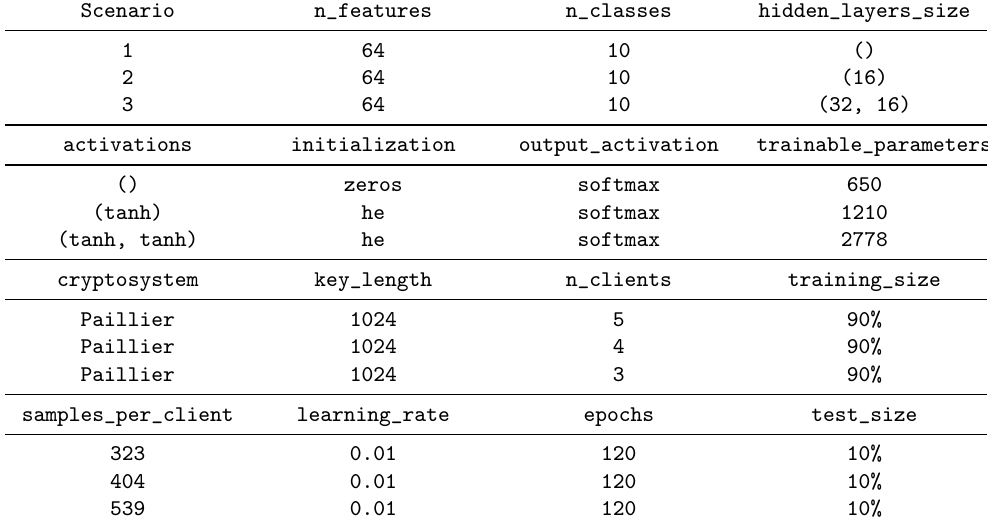
Table 2. Summary of scenarios